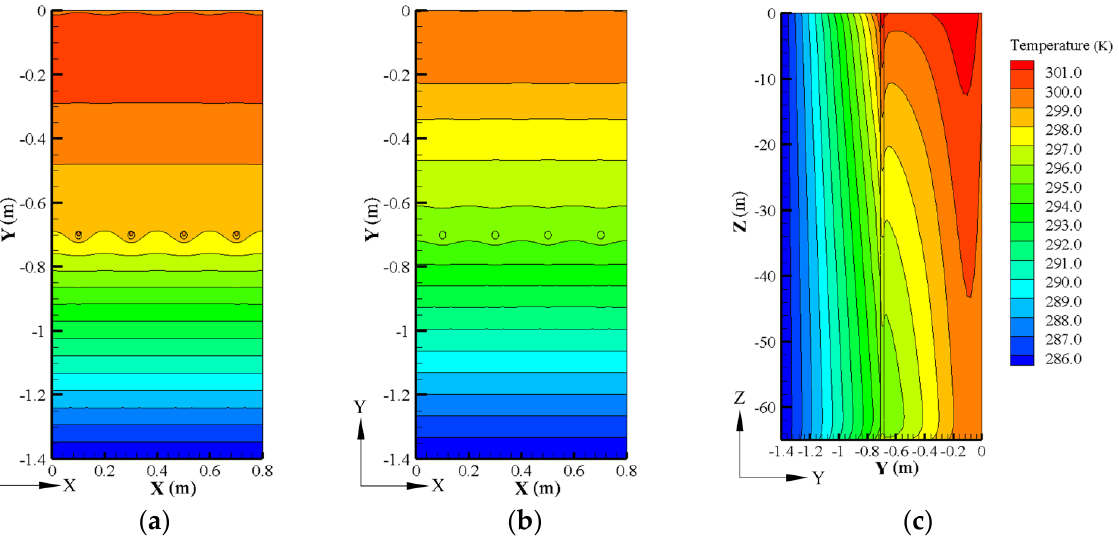
Figure 18. Simulated soil temperature distribution at 0:00 on 24 October 2019. ( a ) Z = − 15 m, ( b ) Z = − 50 m, and ( c ) X = 0.3 m (the X-to-Y ratio is set as 20).